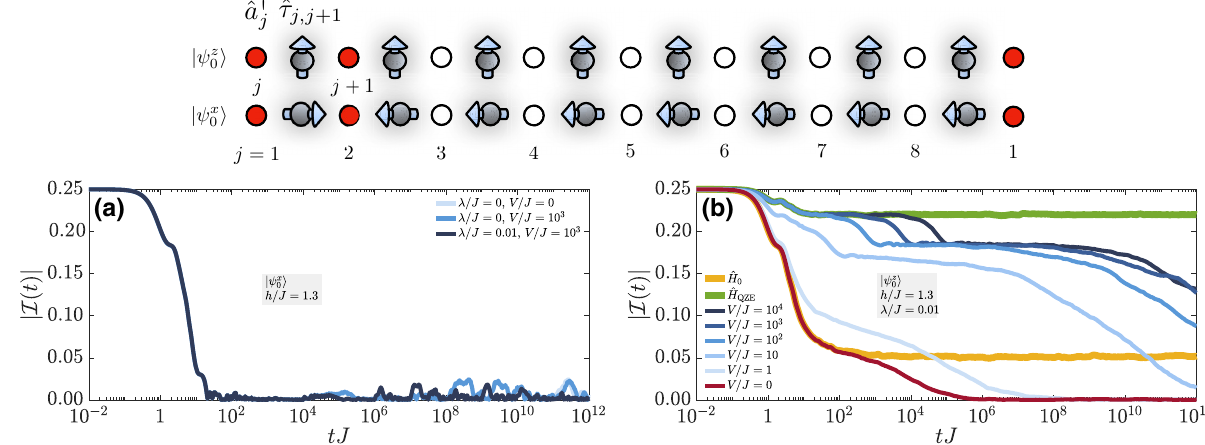
FIG. 10. (a) Same as Fig. 3 but for a system with L = 8 matter sites and L = 8 gauge links at quarter filling in the bosons, with (cid:3) given on top. Disorder-free localization is absent and the system thermalizes with a vanishing the gauge-invariant initial state | ψ x 0 imbalance regardless of the values of λ and V . (b) Same as Fig. 4(b) but for a system with L = 8 matter sites and L = 8 gauge links at quarter filling in the bosons, with the gauge-noninvariant superposition initial state | ψ z disorder-free localization, where the dynamics at sufficiently large V is faithfully reproduced by an emergent gauge theory ˆ H QZE = (cid:2) ˆ P ( ˆ H + λ ˆ H ) ˆ P 0 1 w w , which hosts an enhanced local symmetry associated with the LPG and that includes the original w symmetry, up to a timescale ∝ V / J 2 . After this timescale, a renormalized gauge theory with only the original Z 2 gauge